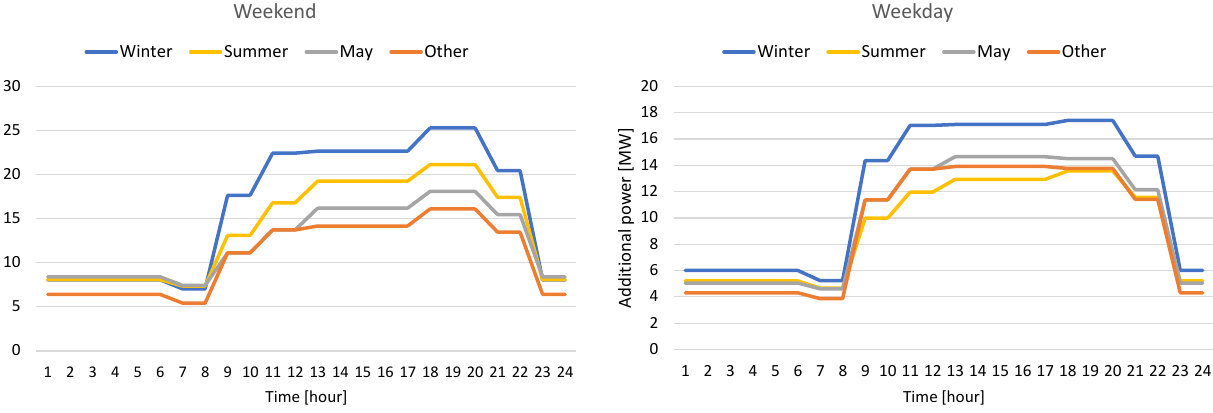
Figure 10. Additional load curve for scenario 4 ( small gas station renaissance ). Winter = November– March, summer = June–August, and other = April, September, and October. For scenarios 1 and 4 (Figures 7 and 10, respectively), the charging power curve is fairly stable (flat) and similar during the daytime, while scenarios 2 and 3 (Figures 8 and 9, respectively) show similar additional charging power curve shapes, having a clear peak moment from 6:00 p.m. to 8:00 p.m. The reason behind this is that in scenarios 1 and 4, charging at public charging stations such as rest stops, which is relatively evenly